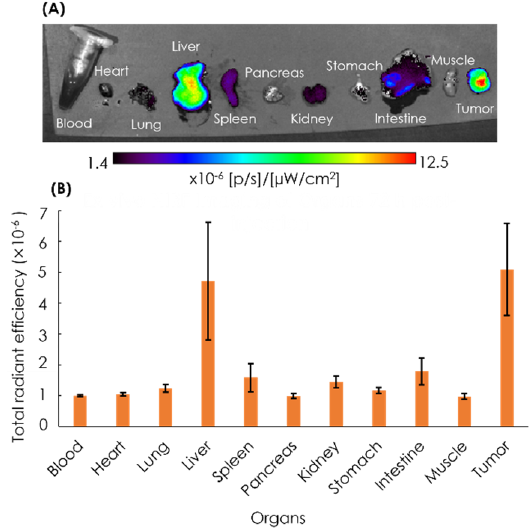
Figure 7. Ex vivo NIRF imaging of organs ( A ) and the quantification of ICG fluorescence ( B ). Ex vivo NIRF imaging of excised organs of the xenografts was performed at 72 h post-injection with ICG-labeled AB-Lac particles. Data are expressed as mean ± S.E.M. ( n = 4).